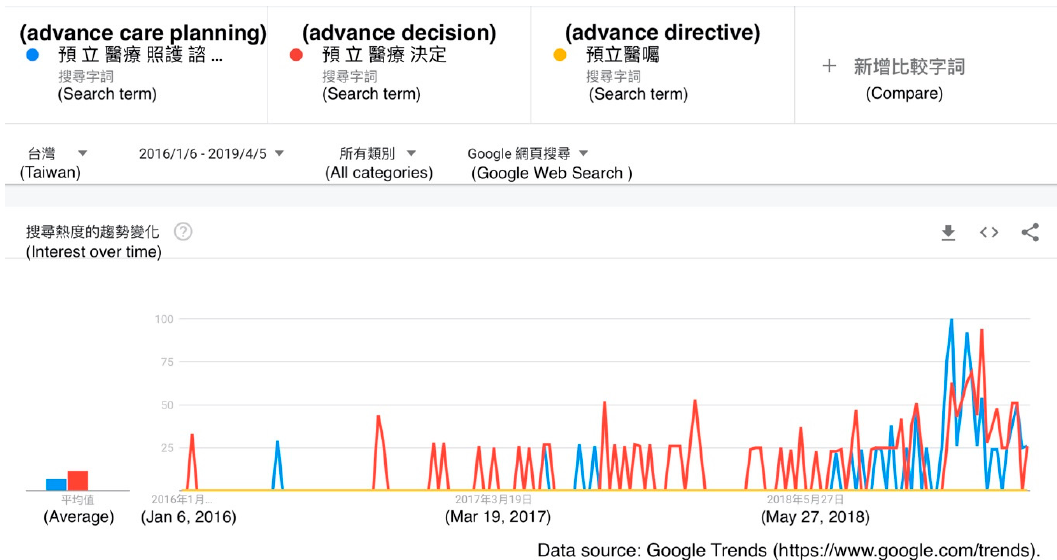
Figure 2. A Google Trends graph for the terms “advance care planning” (blue line), “advance decision” (red line), and “advance directive” (yellow line) in Taiwan from 6 January 2016 to 5 April